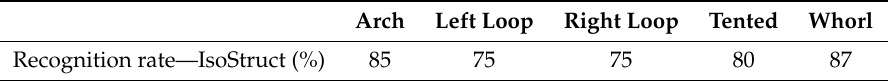
Table 8. Fingerprint classification results with the IsoStruct features vector.